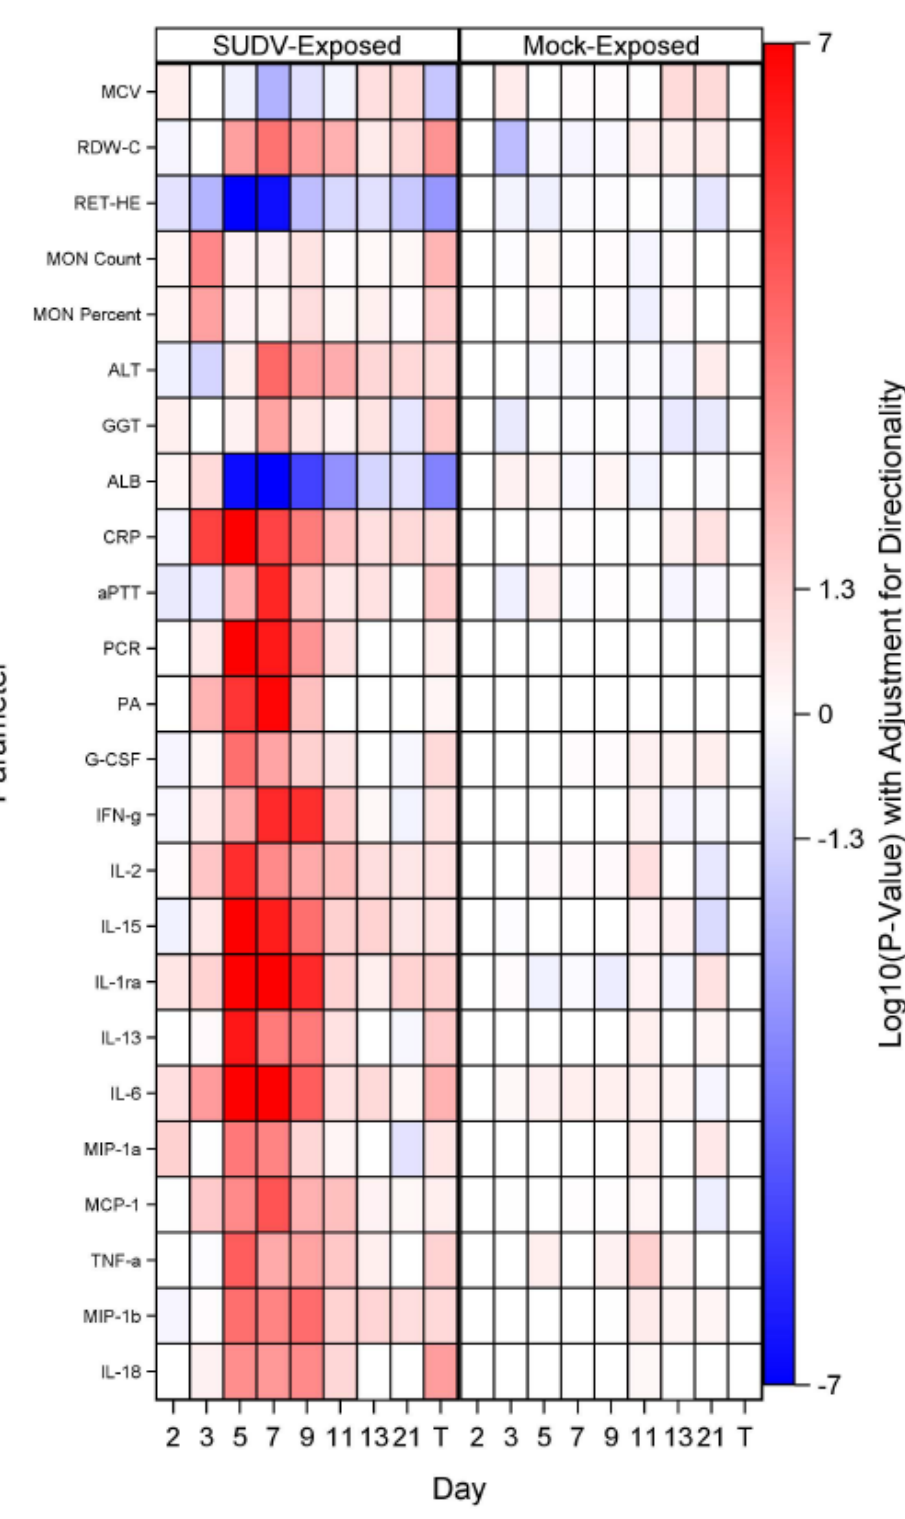
Figure 11. Onset of Abnormality Heat Map. T represents Terminal (data collected from animals that met euthanasia criteria were combined and reported as a single terminal time point).